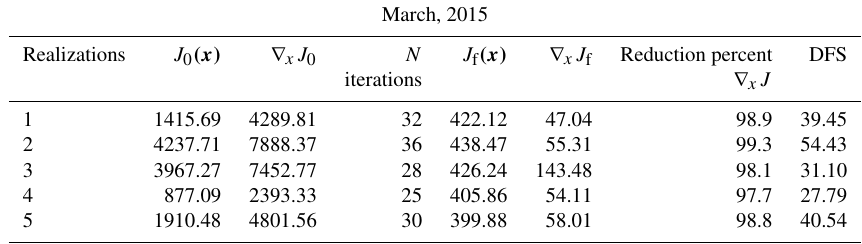
Table A1. Convergence diagnostic of the inversion system using an ensemble of five independent OSSEs for March 2015 ( ∇ x J 0 and ∇ x J 0 represent the initial cost function and its gradient at the beginning of the optimization and ∇ x J f and ∇ x J f are for the end of the optimization).